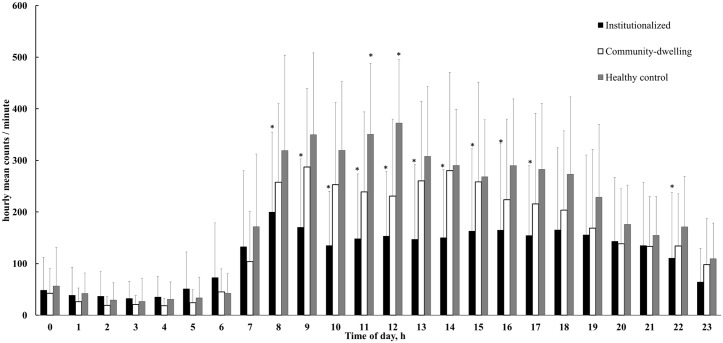
Daily physical activity (PA) pattern in older adults with and without dementia.The figure shows the hourly PA during the day based on minute-averaged data, starting at midnight (0). The first bars show the hourly mean counts/minute from 0:00 to 1:00 h. Filled bars: dementia patients living in an institution. Open bars: community-dwelling dementia patients. Gray bars: community-dwelling healthy older adults. Values are mean (and standard deviation). *, different to community-dwelling dementia patients (p < 0.05).